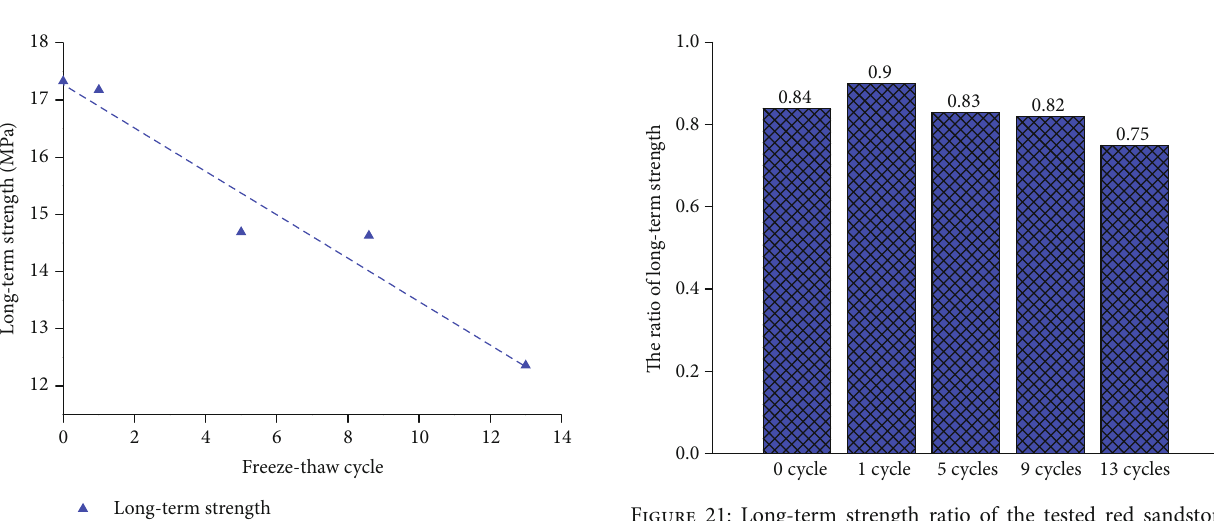
Figure 19: Steady creep rate of the tested red sandstone under (a) 0, (b) 1, (c) 5, (d) 9, and (e) 13 numbers of freeze-thaw cycles.